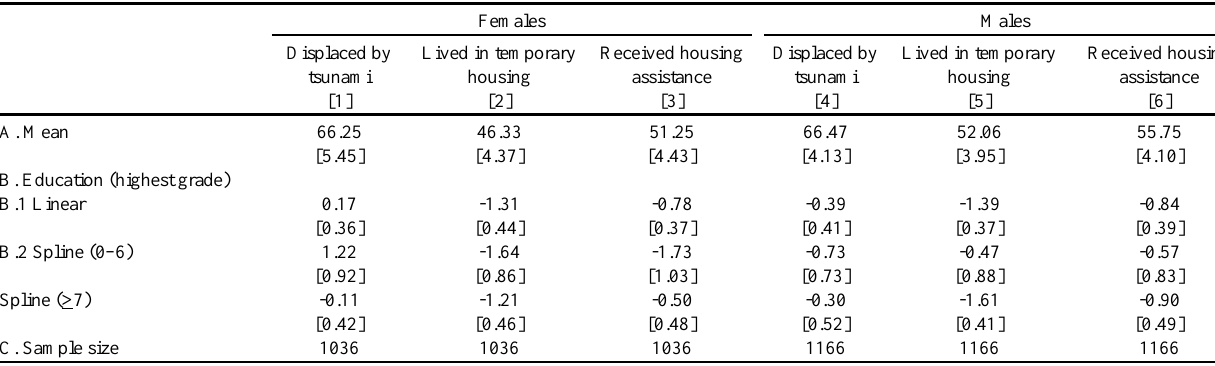
Table 3. Displacement and receipt of housing